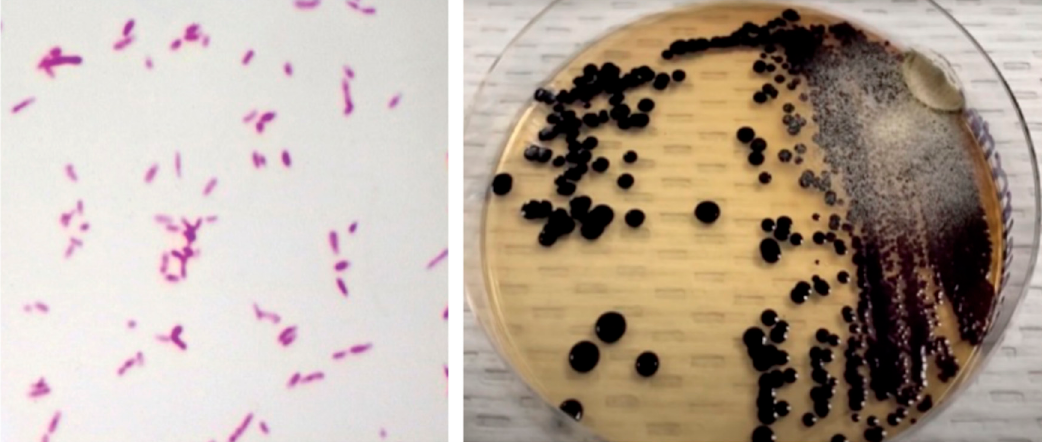
Figure 2. ( Left ) Gram stain of skin abscess showing Gram-negative coccobacillary forms. ( Right ) nutritive agar with black-violet mucoid colonies consistent with Chromobacterium violaceum.